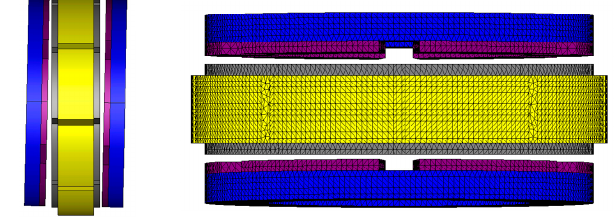
Figure 11. The 3D FE model and its meshing.